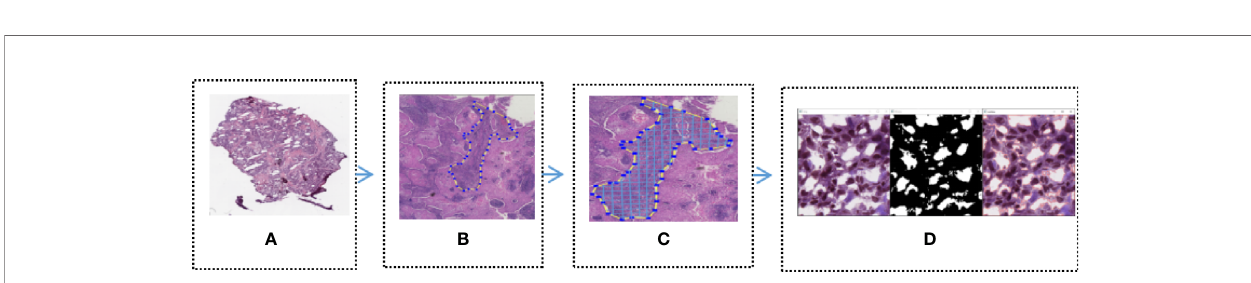
FIGURE 1 | Study fl ow chart (A) Download images from The Cancer Genome Atlas database; (B) identify tumor areas; (C) color normalization; (D) biomarker recognition; (E) heat map.